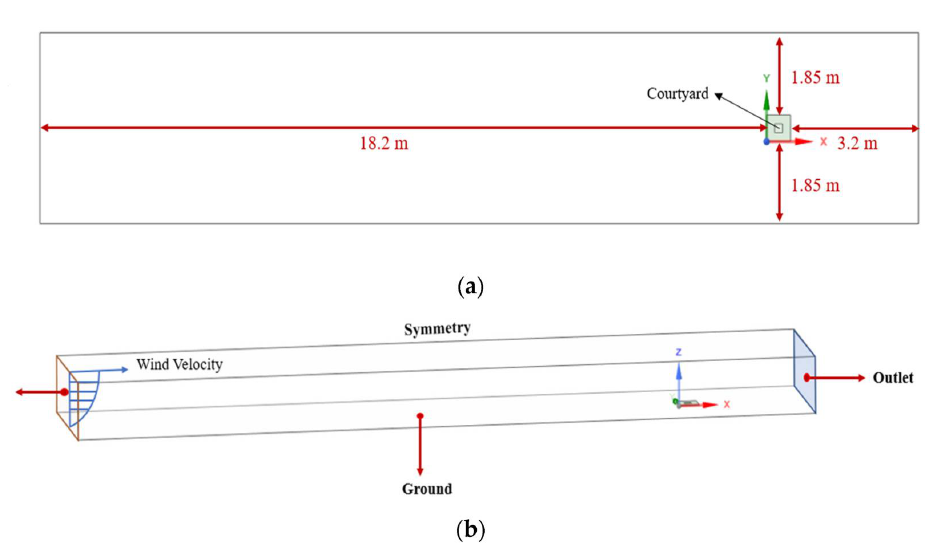
Figure 10. ( a ) Simulation domain of the validation model. ( b ) The dimension of the validation